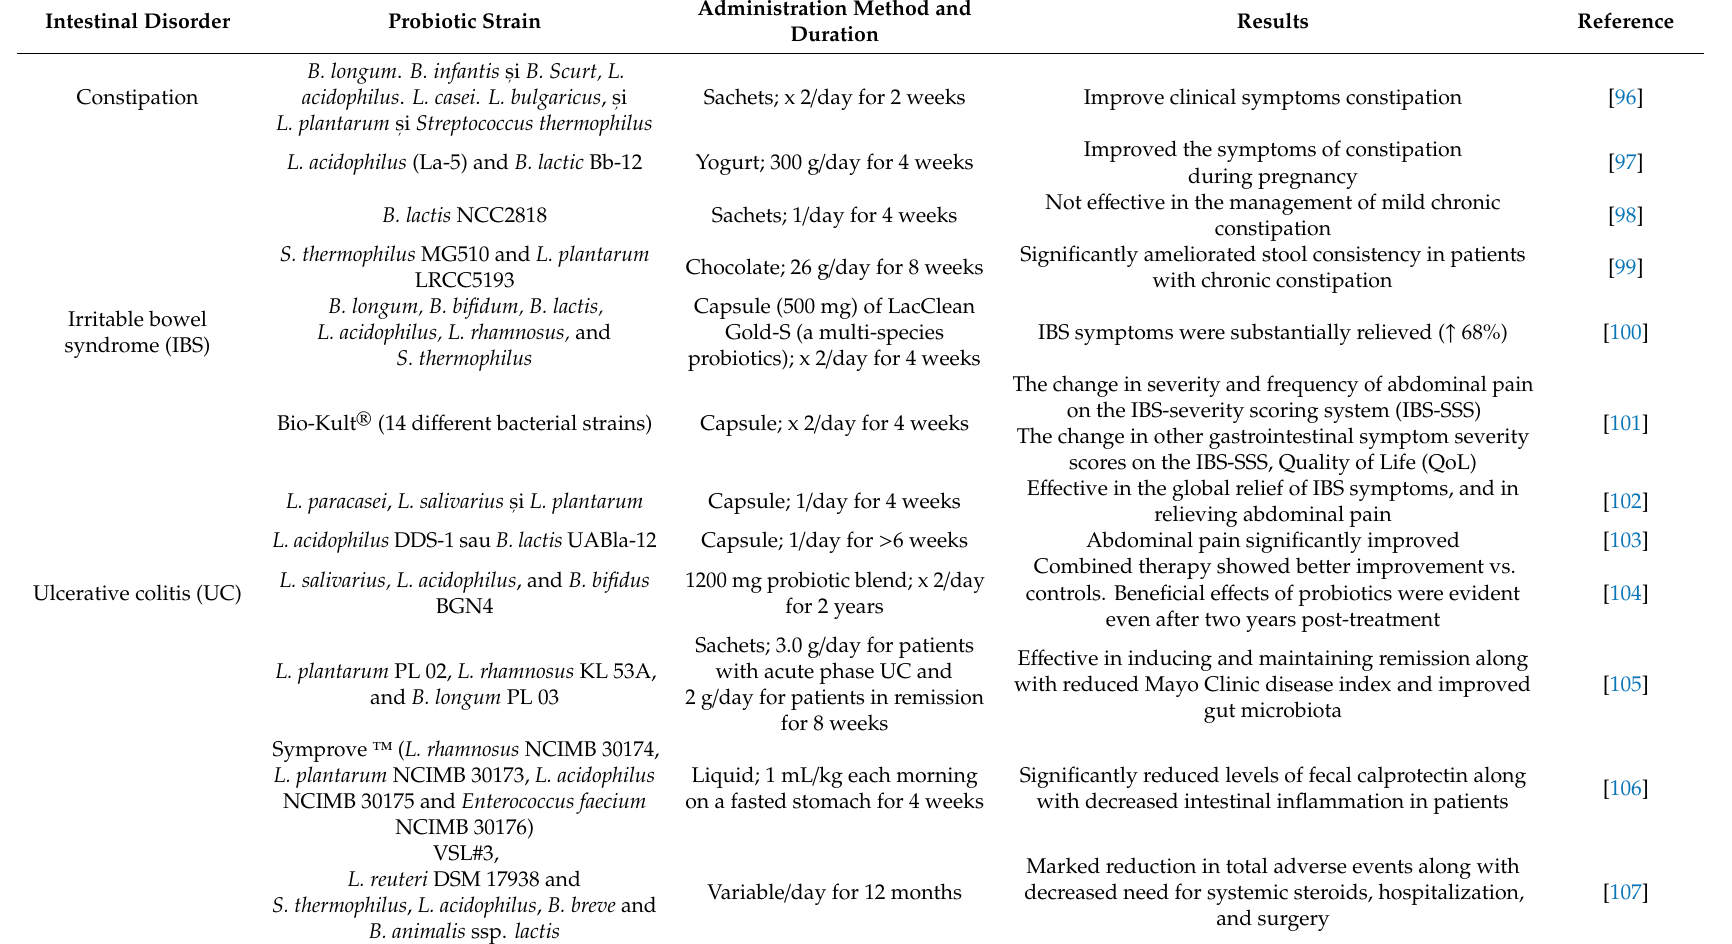
Table 1. Probiotics e ff ect in intestinal